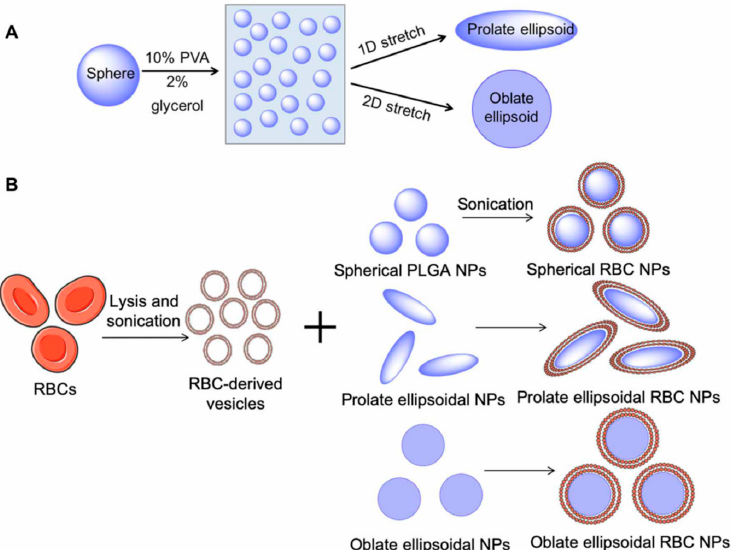
Figure 12. Schematic of anisotropic nanoparticle fabrication and RBC membrane coating. ( A ) Spherical PLGA nanoparticles (NPs) were synthesized and cast onto a thin plastic film of 10% polyvinyl alcohol (PVA) and 2% glycerol. Particles were then stretched under heat in one and two dimensions (2D) to generate prolate and oblate ellipsoidal particles, respectively. ( B ) RBCs underwent hypotonic lysis and were then sonicated to generate sub—200 nm vesicles. RBC-derived vesicles were then coated on PLGA nanoparticles of all shapes under sonication. (Reprinted from [33], license CC BY 4.0.)